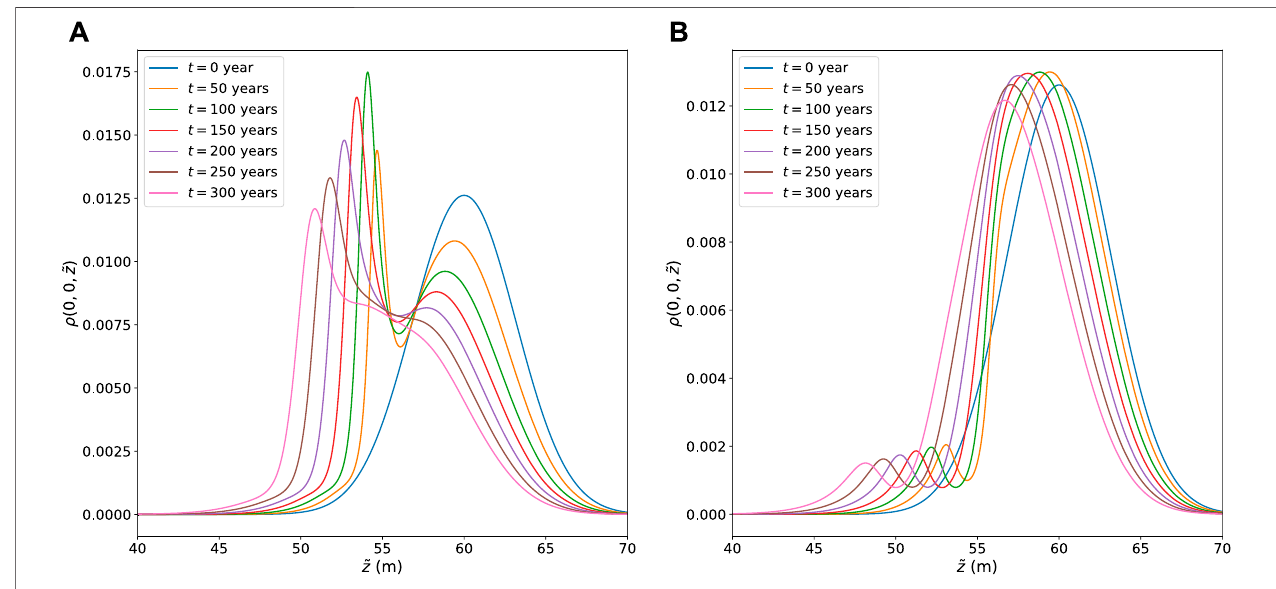
FIGURE 4 | Effect of nutrients on the particle dynamics. Evolution of the probability density function along the ~ z -axis, at ~ x (cid:2) ~ y (cid:2) 0, for two values of the chemotaxis strength β is computed using a fi nite difference method. The particle radius is R = 10 − 6 m, the concentration of impurities is N = 100 μ M m − 2 , the temperature gradient is | ∇ T | = 0.1K m − 1 and the active diffusivity is ~ D a (cid:2) 100 ~ D .